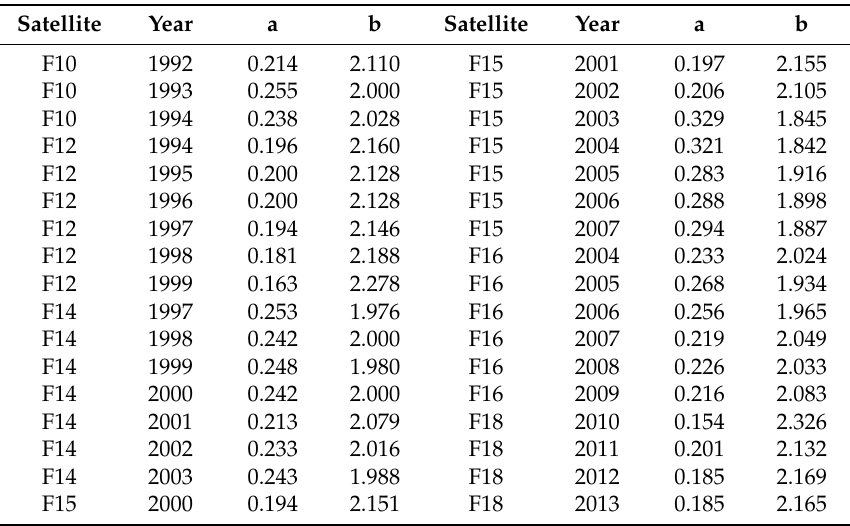
Table 1. Coefficients of the regression models for